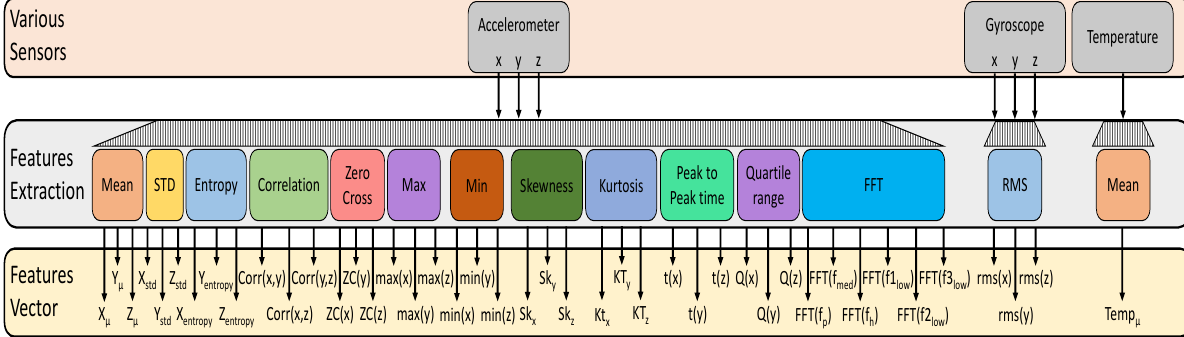
Figure 4. Feature vector construction.